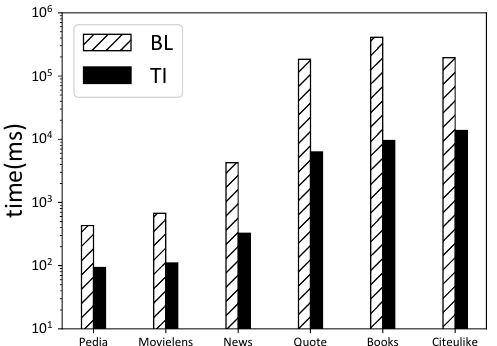
Figure 3. Efficiency evaluation of the time-improved